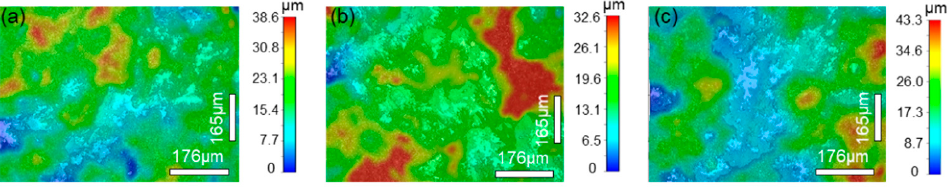
Figure 15. LSCM images of the wear tracks on the WC–10Co4Cr coating at ( a ) 1000 g, ( b ) 1500 g, and ( c ) 2000 g. ( c ) 2000